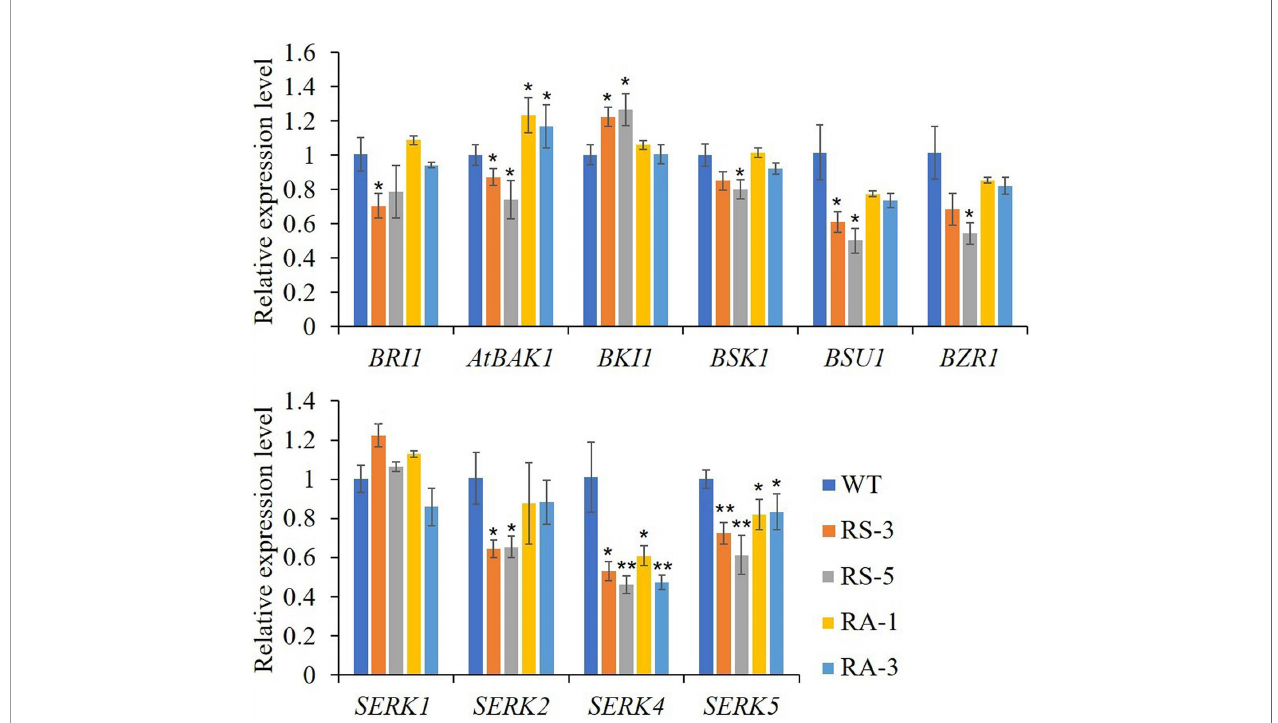
FIGURE 5 | qRT-PCR analysis of genes related to BR signaling pathway and the SERKs family. WT, wild type; RS-3 and RS-5, ZmRLK7 sense transgenic lines; RA-1 and RA-3, ZmRLK7 antisense transgenic lines. AtUBQ10 mRNA level was used as internal control. Values are means of three biological replicates with SD. * and ** denote signi fi cant differences at p < 0.05 and 0.01 by ANOVA, respectively. All comparisons were with the WT as the